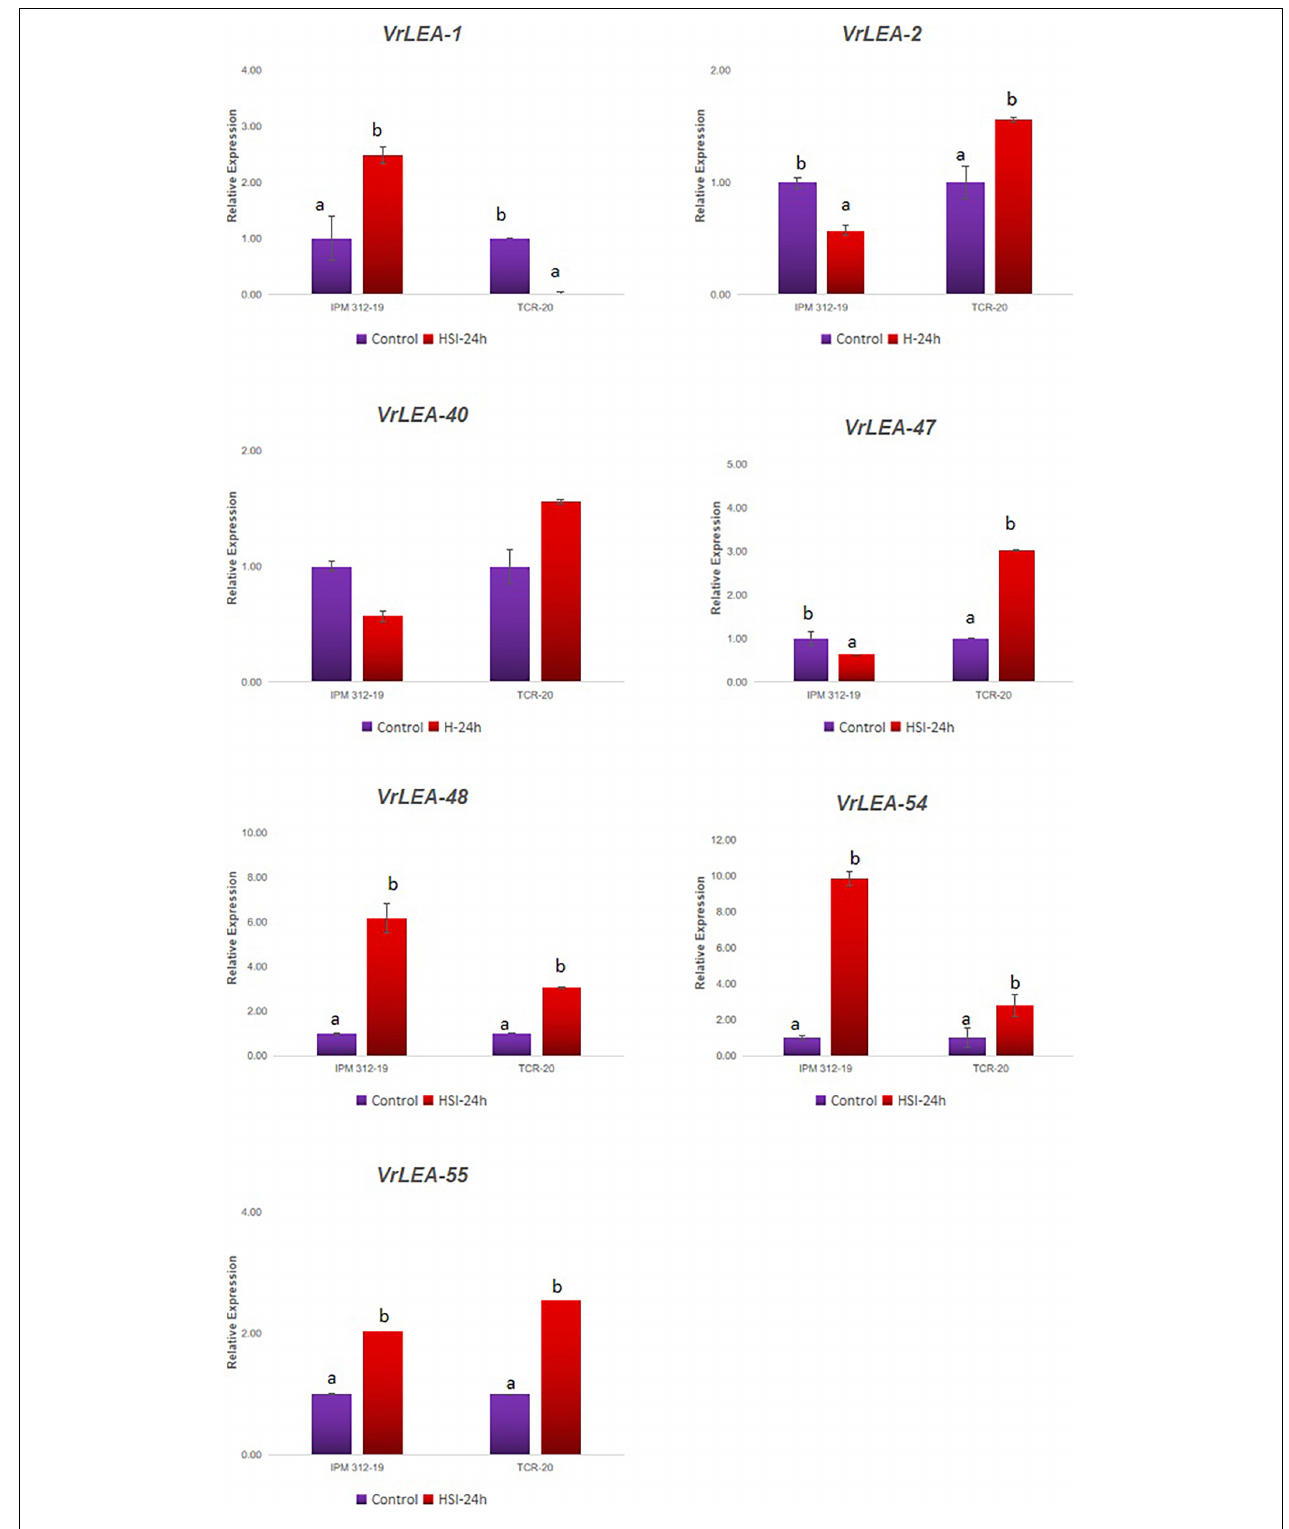
FIGURE 8 | qRT-PCR analysis of selected VrLEA candidate genes on HS-mungbean (IPM 312-19) and HR- V. glabrescens (IC251372) under heat shock stress at seedling stage. The statistical test was performed separately in both genotypes. The same letters show non-significant differences, whereas different letters show significant